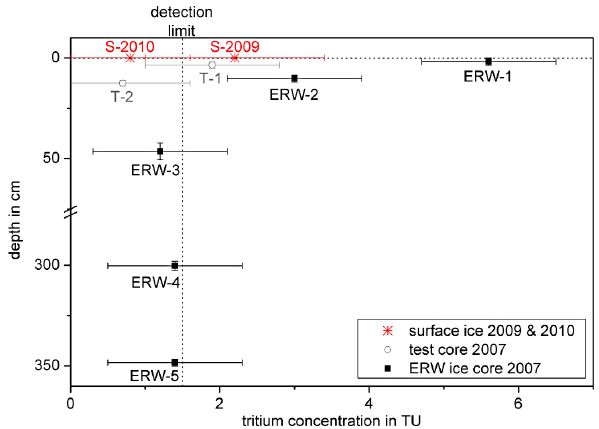
Fig. 3. Tritium concentration in five samples from the ERW ice core (black), two samples from the parallel-drilled test core (gray), and two surface samples taken in 2009 and 2010 (red). Note the break in the y-axis from 75 to